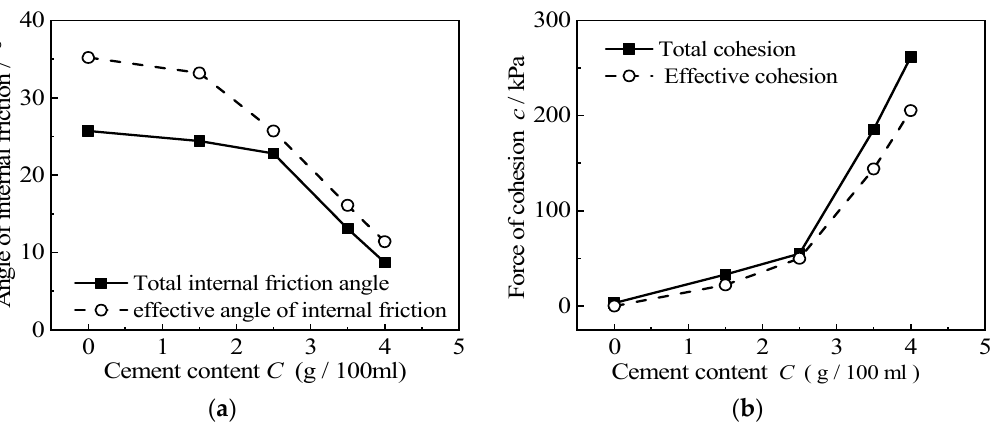
Figure 17. The relationship between the shear strength index of RCS soil and cement content when X = 20%. ( a ) Relationship between cement content and internal friction angle, ( b ) Relationship between cement content and cohesion.